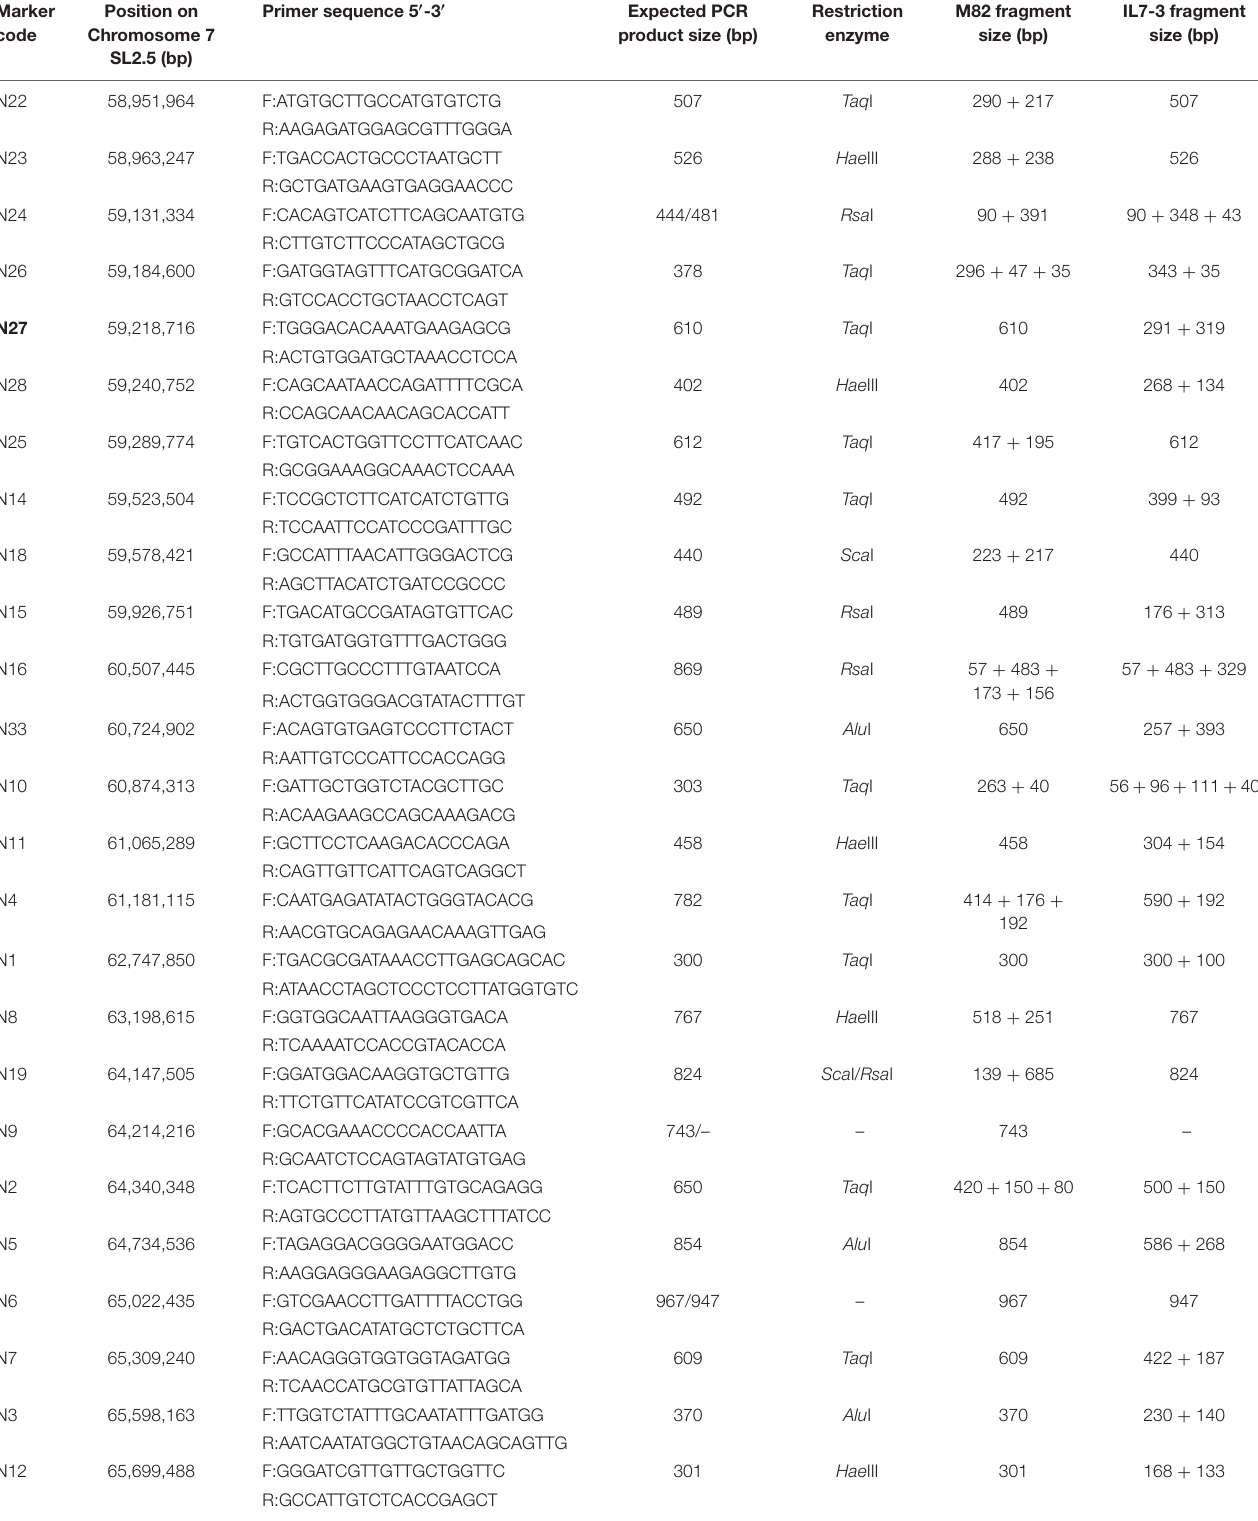
TABLE 2 | CAPS molecular markers used to define the whole introgression region 7-3 and the sub-lines obtained from this region. Marker Position on code Chromosome 7 SL2.5